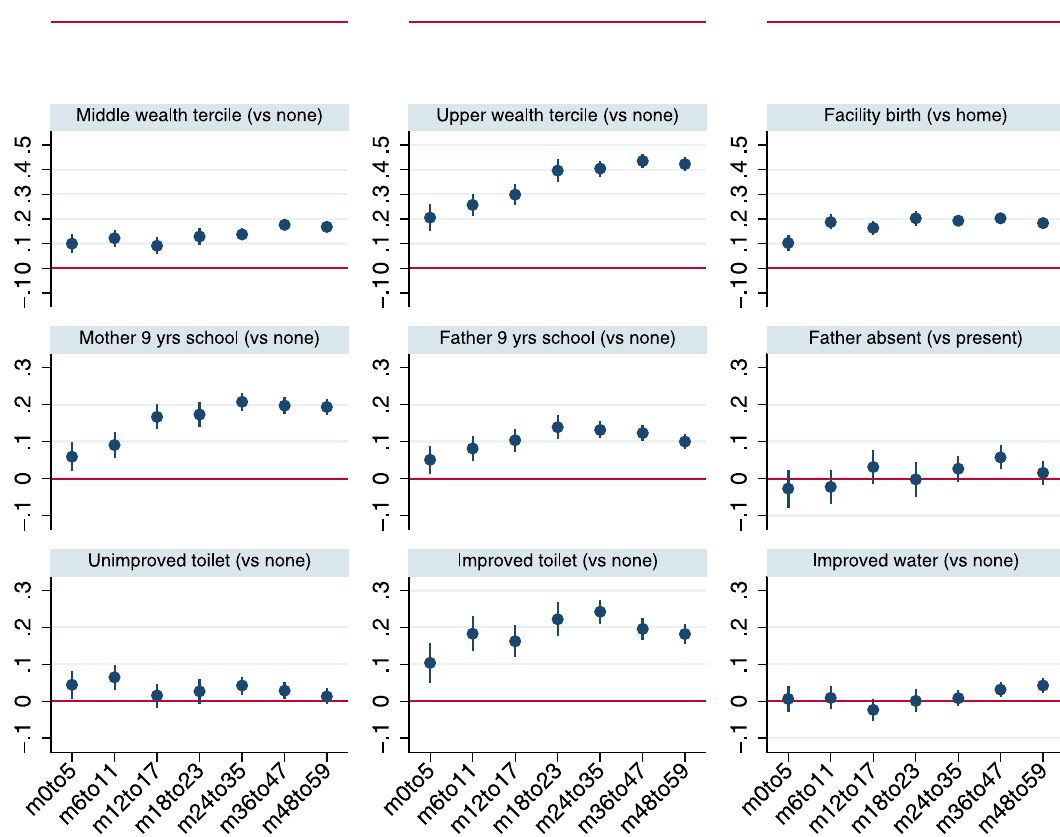
Fig 3. Least squares estimates for HAZ scores by age-restricted sub-samples: Household wealth, health facility access, parental education, household sanitation and water variables. Notes: The figure reports coefficients and 95% confidence intervals based on cluster-adjusted standard errors from multivariable least squares regressions of HAZ against all the variables listed in Table 1, as well as country-year fixed effects and dummy variables for every month of child age. Samples sizes for the regressions estimated for the various age groups are 67,384 (0–5 months; m0to5 ),75,965 (6–11 months; m6to11 ),76,711 (12–17 months; m12to17 ),68,694 (18–23 months; m18to23 ),129,174 (24–35 months; m24-35 ),138,342 (36–47 months; m36to47 ), 132,242 (48–59 months; m48to59 ).